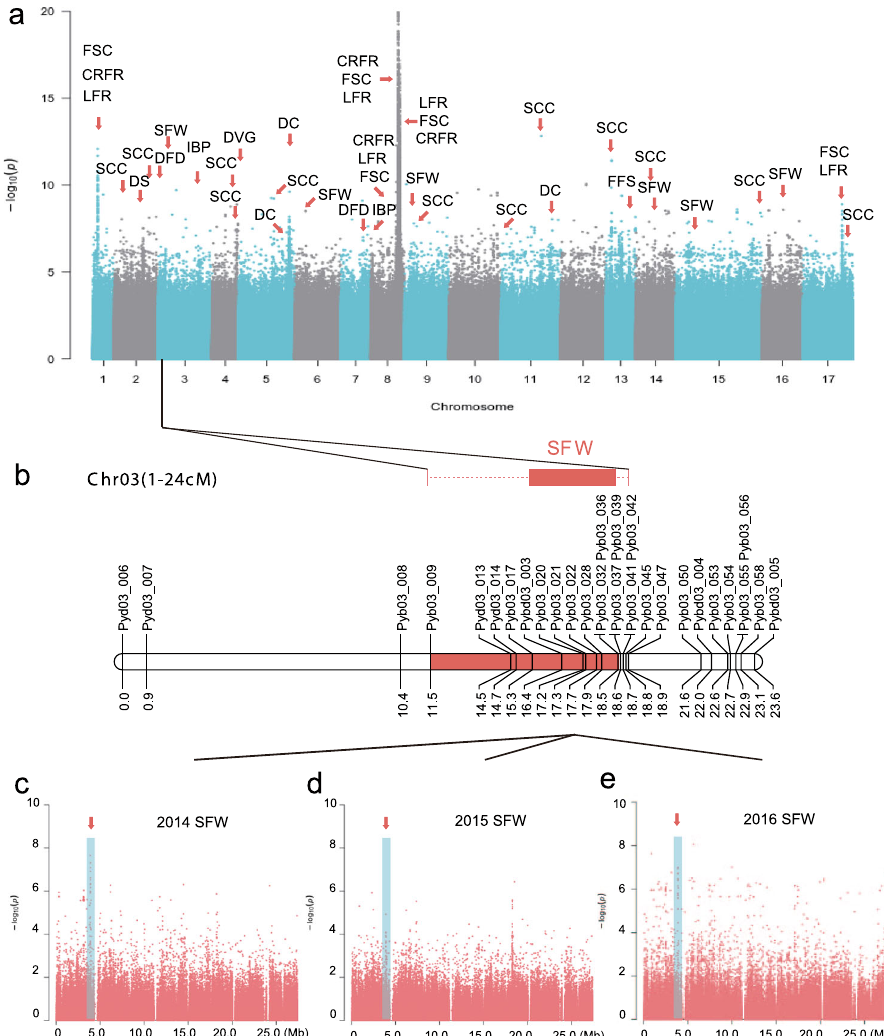
Fig. 3 GWAS of 11 traits in 312 sand pears. a Manhattan plot of GWAS for 11 traits in sand pears. IBP initial bloom period, DFD days of fruit development, DVG days of vegetative growth, FSC fruit skin color, CRFR coverage ratio of fruit russet, LFR location of fruit russet, FFS furrows on fruit surface, DC direction of carpopodium, DS direction of sepal, SFW single fruit weight, SCC stone cell content. b QTL for trait of single fruit weight in the population of ‘ Bayuehong ’ × ‘ Dangshansuli ’ . c – e Manhattan plots of chromosome 3 of GWAS for trait of single fruit weight in the years 2014 ( c ), 2015 ( d ), and 2016 ( e